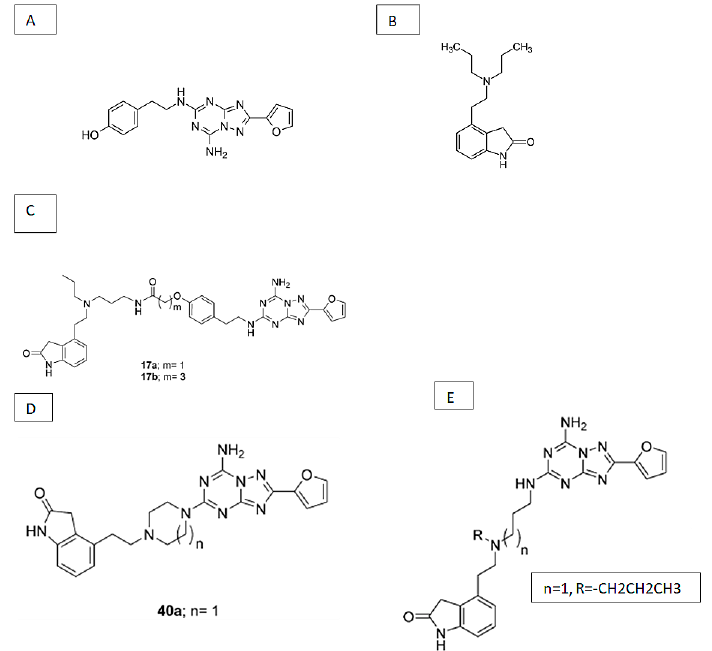
Figure 5. Conjugation of the adenosine A 2A R antagonist ZM241385 ( A ) and the dopamine D 2 ago- nist ropinirole ( B ) to form a heterobivalent ligand ( C ). Dual action drugs can be prepared by using cyclic ( D ) or non-cyclic ( E ) spacers, and the latter may contain an ionizable tertiary amine